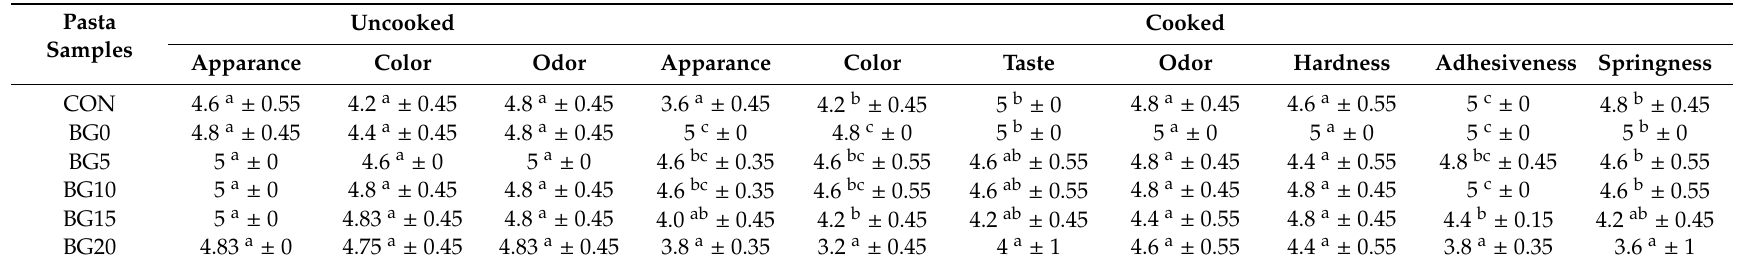
Table 7. Organoleptic quality of pasta